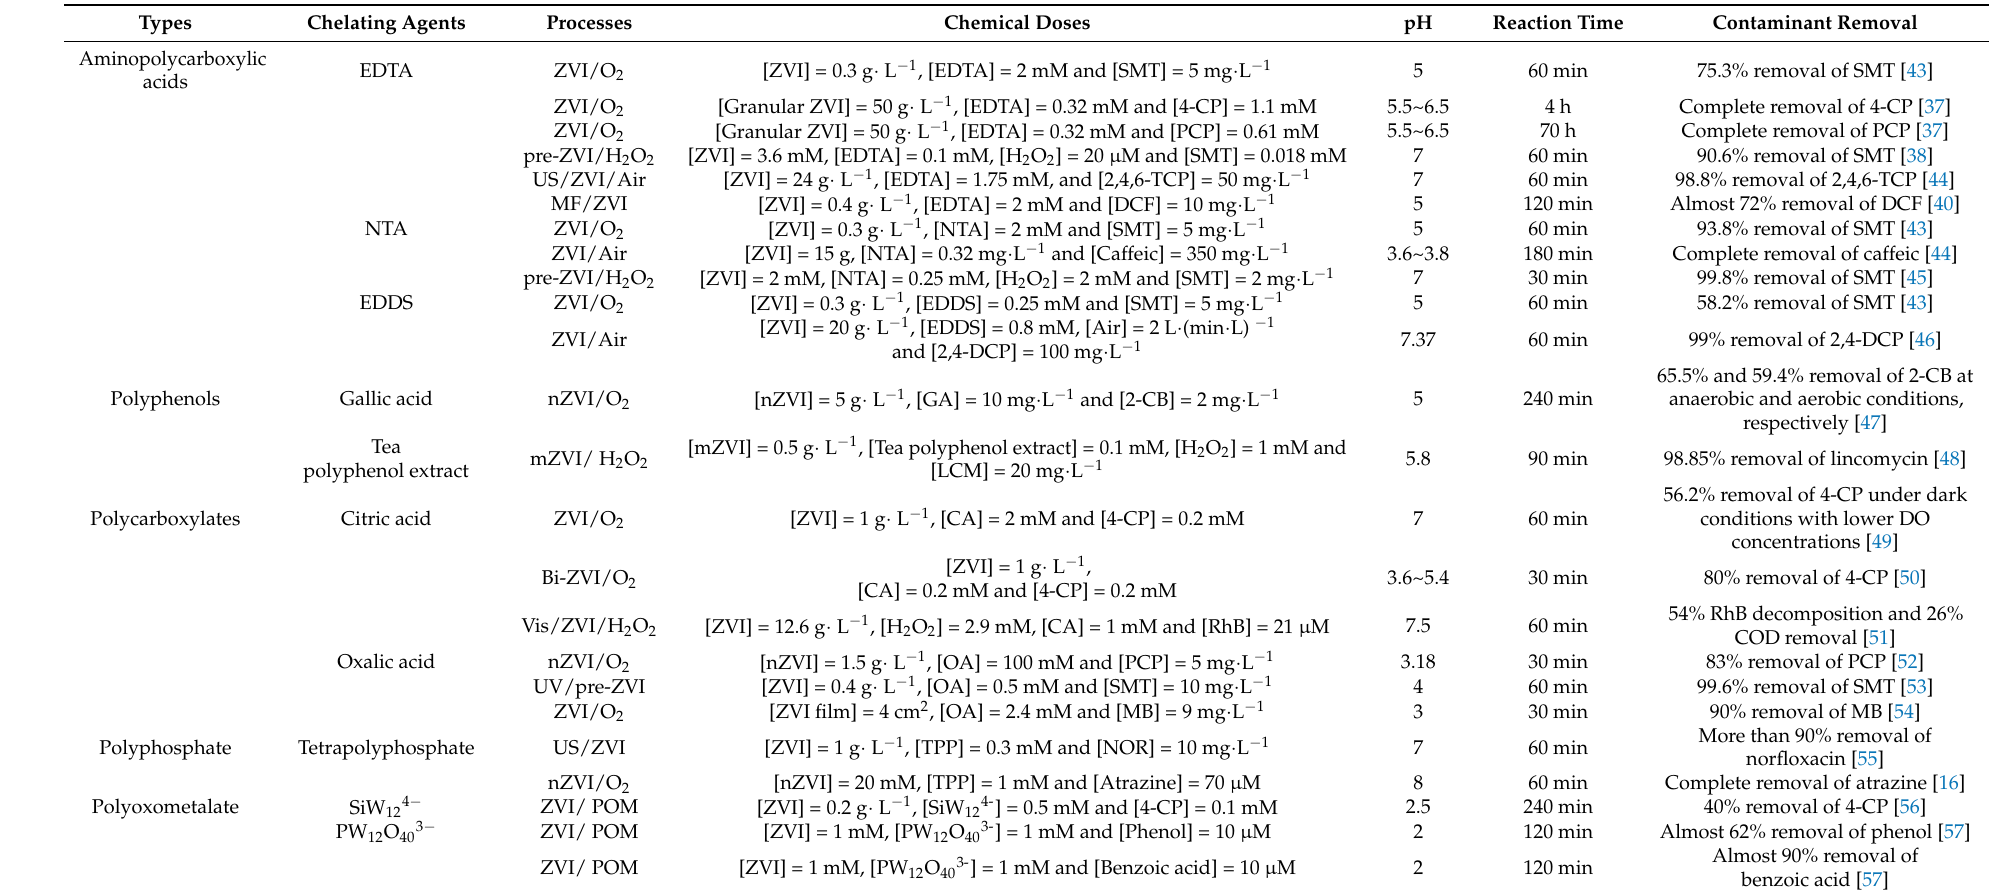
Table 1. Degradation Efficiencies of Organic Contaminants by Chelating Agents Enhanced ZVI Systems in Selected